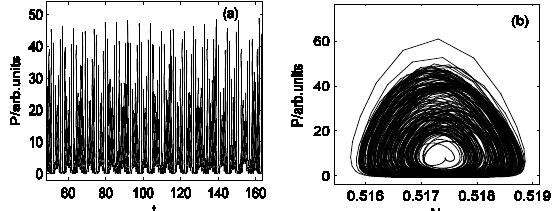
Fig. 5. Chaos. (a) another chaotic movement. (b) another chaotic attractor.